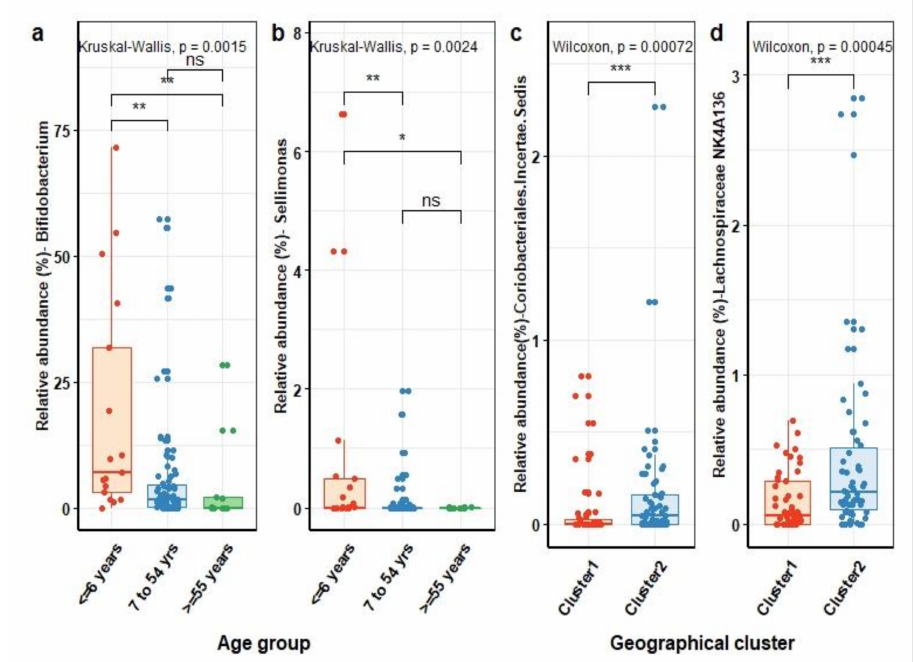
Figure 2. Human gut microbial genera in association with age and geographical location. Compar- ison of relative abundance (%) of Bifidobacterium ( a ) and Sellimonas ( b ) genera across age groups. Comparison of relative abundance (%) of Coriobacteriales incertae sedis ( c ) and Lachnospiraceae NK4A136 ( d ) between individuals living in the two geographical clusters. Symbols show the statistical signifi- cance levels, ns indicates p > 5 × 10 − 2 , * indicates p < 5 × 10 − 2 , ** indicates p < 1 × 10 − 2 , *** indicates p < 1 × 10 − 3